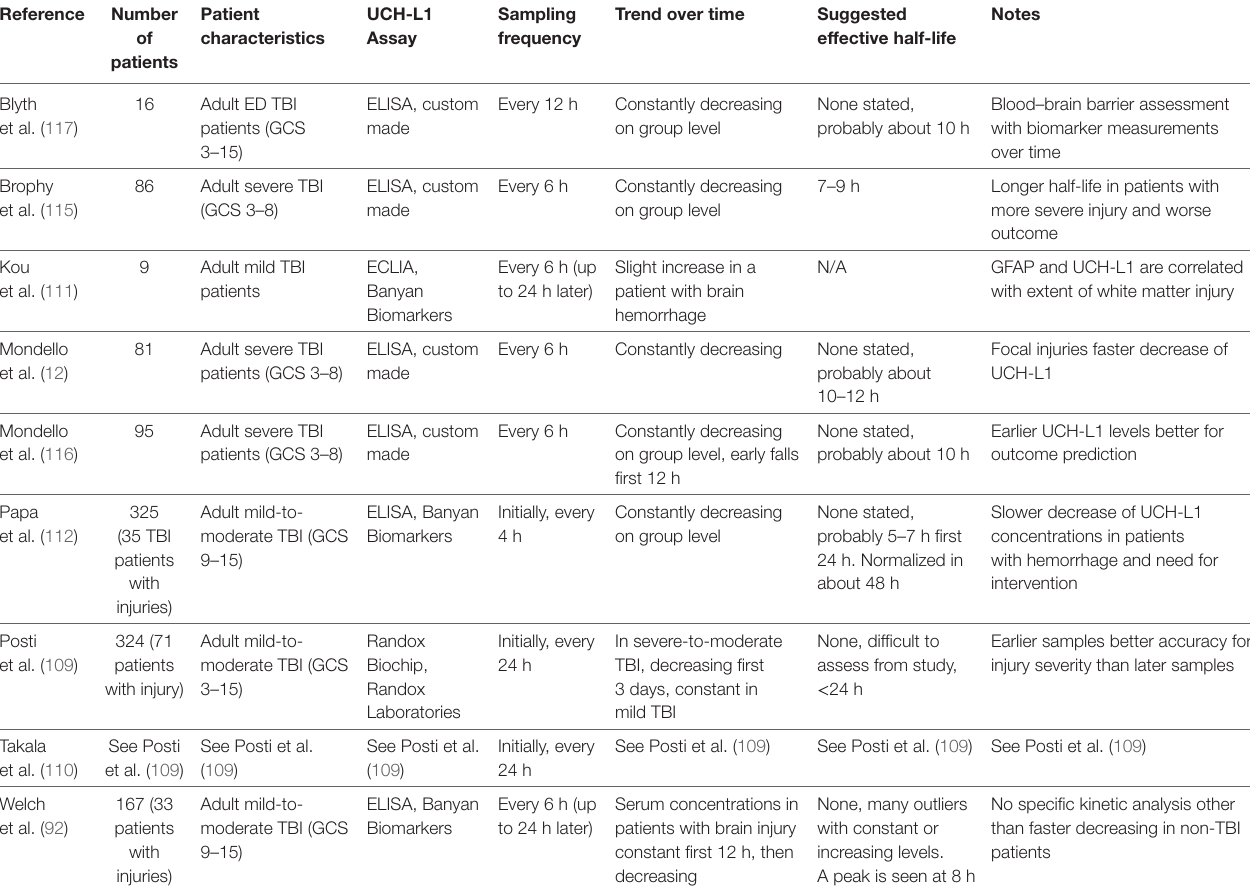
TABLe 4 | Analysis of UCH-L1